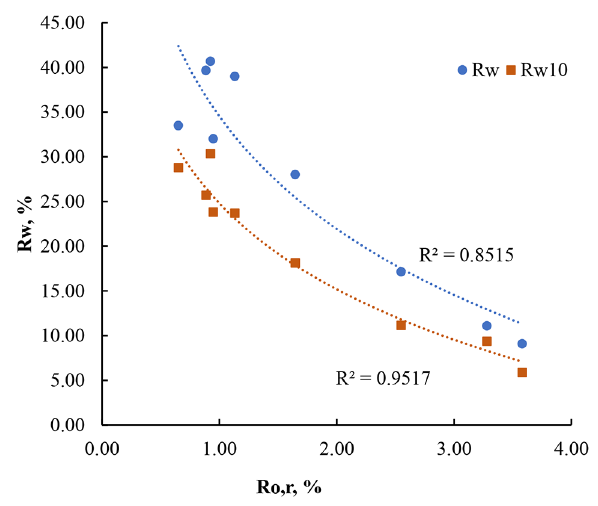
Fig. 6 Correlations between coals vitrinite reflectance and their ability to crushing (damage indices)